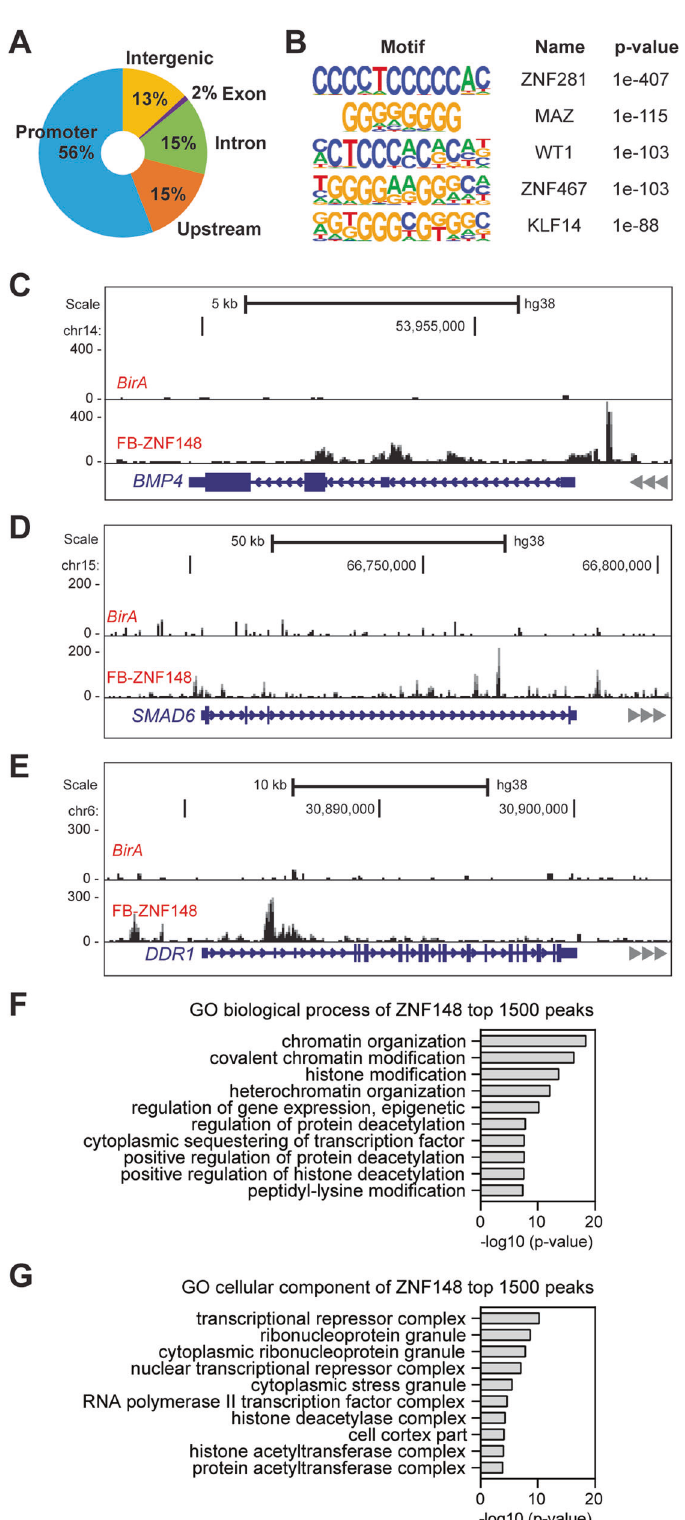
Fig. 4 Genomic targets of ZNF148. A Doughnut chart showing the percentage distribution of ZNF148 chromatin occupancy peak locations determined by BioChIP-seq. B Consensus DNA binding motif analysis of ZNF148 occupied sequences (HOMER) [43]. The top 5 representative DNA binding sequence motifs were ranked by p -value and known transcription factors. C Representative BioChIP-seq signals at the bone morphogenetic protein 4 ( BMP4 ) locus in MDA-MB-231 cells expressing BirA alone or BirA and FB-ZNF148. D As in “ C ” for SMAD family member 6 ( SMAD6 ) locus. E As in “ C ” for discoidin domain receptor tyrosine kinase 1 ( DDR1 ) locus. F GO biological process analysis of ZNF148 top 1500 peaks. G GO cellular component analysis of ZNF148 top 1500